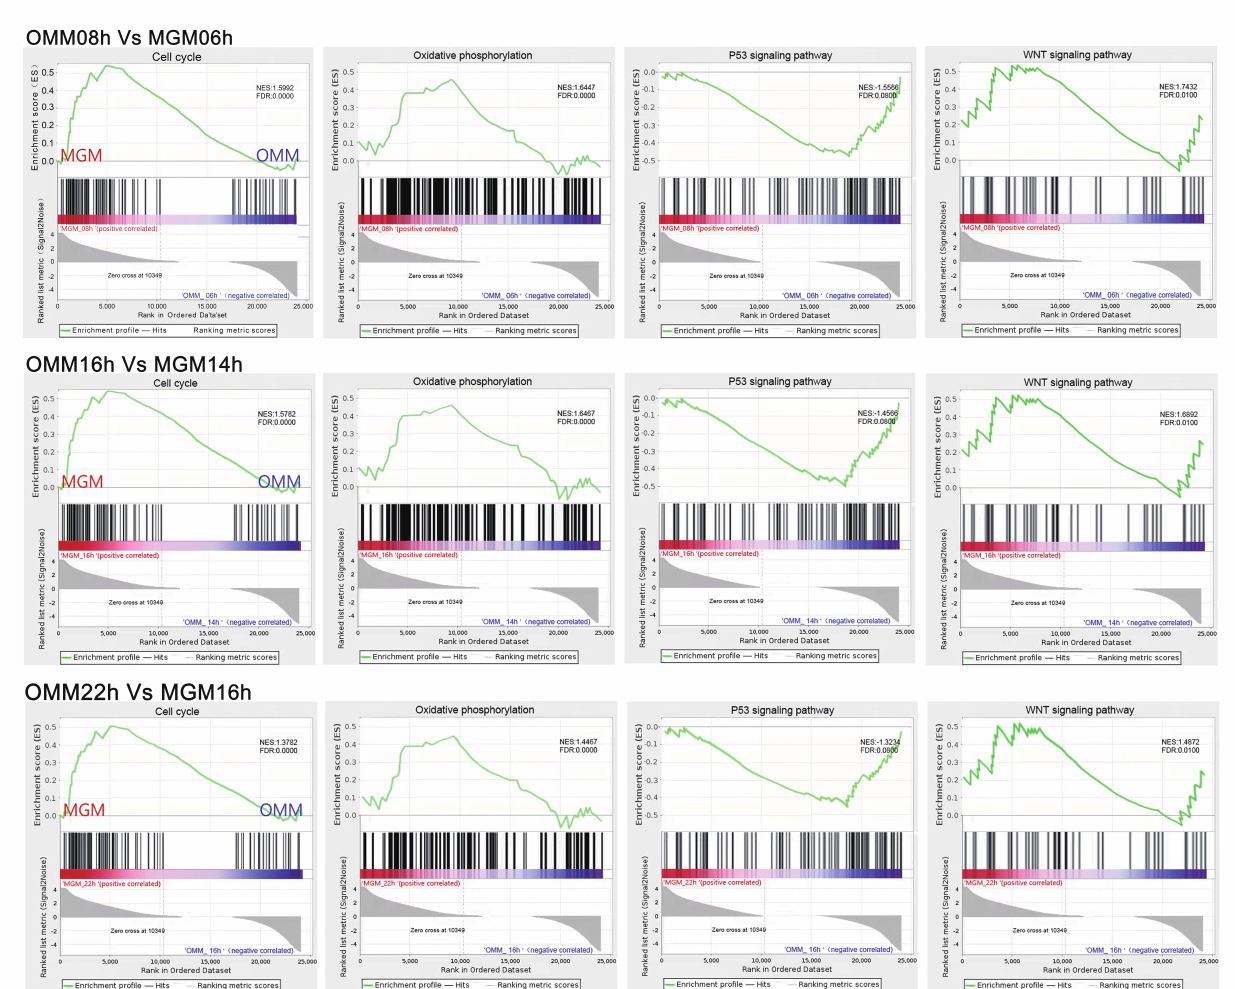
Figure 4. Gene set enrichment analysis (GSEA) of different time points. The green line shows the enrichment profile. NES: normalized enrichment score, FDR: false discovery